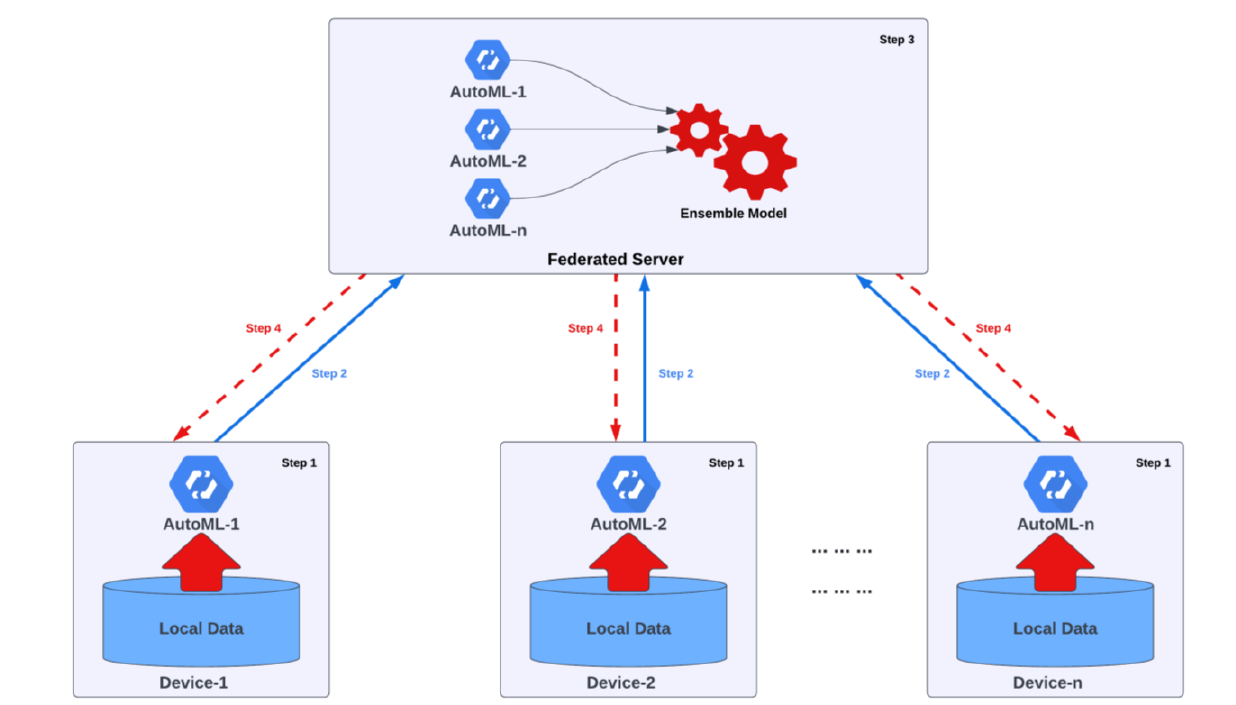
Figure 1. The proposed block diagram of the FAMEL framework.